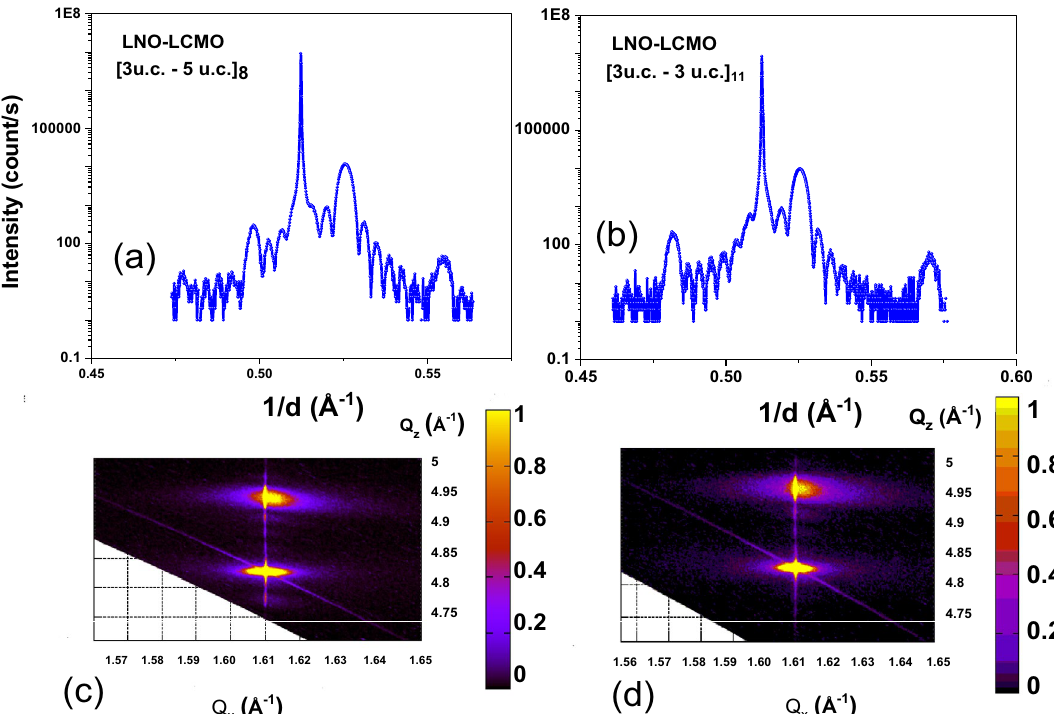
Figure 1. ( a , b ) shows the high-resolution hard X-ray structural characterization for SLs consisting of [3-LNO– 5-LCMO] 8 and [3-LNO–3-LCMO] 11 . ( c , d ) shows the reciprocal space mapping (RSM) around (013)-STO, for both superlattices ( a ) and ( b )